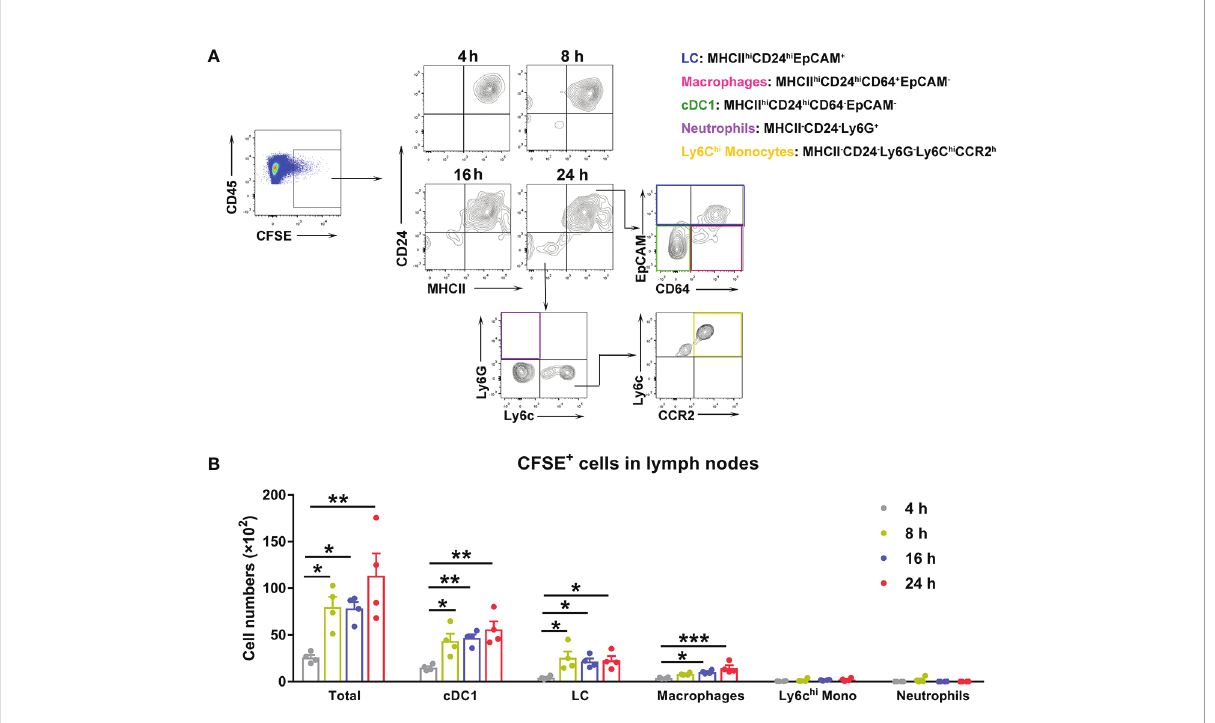
FIGURE 4 Ot infected dendritic cells and macrophages, which migrated to draining lymph nodes in mice. B6 mice (n=4/group) were i.d. infected with CFSE-labeled Ot (4×10 3 FFU) in the ears. dLN were harvested at indicated time-points, and prepared for single cell suspension, followed by fl ow cytometric analysis. (A) Live cells were sorted by live/dead dye staining, and Ot -infected immune cells were identi fi ed by expression of CD45 + CFSE + . We determined that Ot infected the following immune cell subpopulations: Langerhans cells (MHCII hi CD24 hi EpCAM + ), macrophages (MHCII + CD24 hi CD64 + EpCAM - ), conventional dendritic cells (MHCII hi CD24 hi CD64 - EpCAM - ), neutrophils (MHCII - CD24 - Ly6G + ), and Ly6C hi monocytes (MHCII - CD24 - Ly6G - Ly6C hi CCR2 hi ). (B) The absolute Ot -infected cell numbers in dLN were calculated. Values are shown as mean ± SEM from single experiments and are representative of two independent experiments. A one-way ANOVA with Tukey ’ s multiple comparisons test was used for statistical analysis. *, p <0.05; **, p <0.01; ***, p <